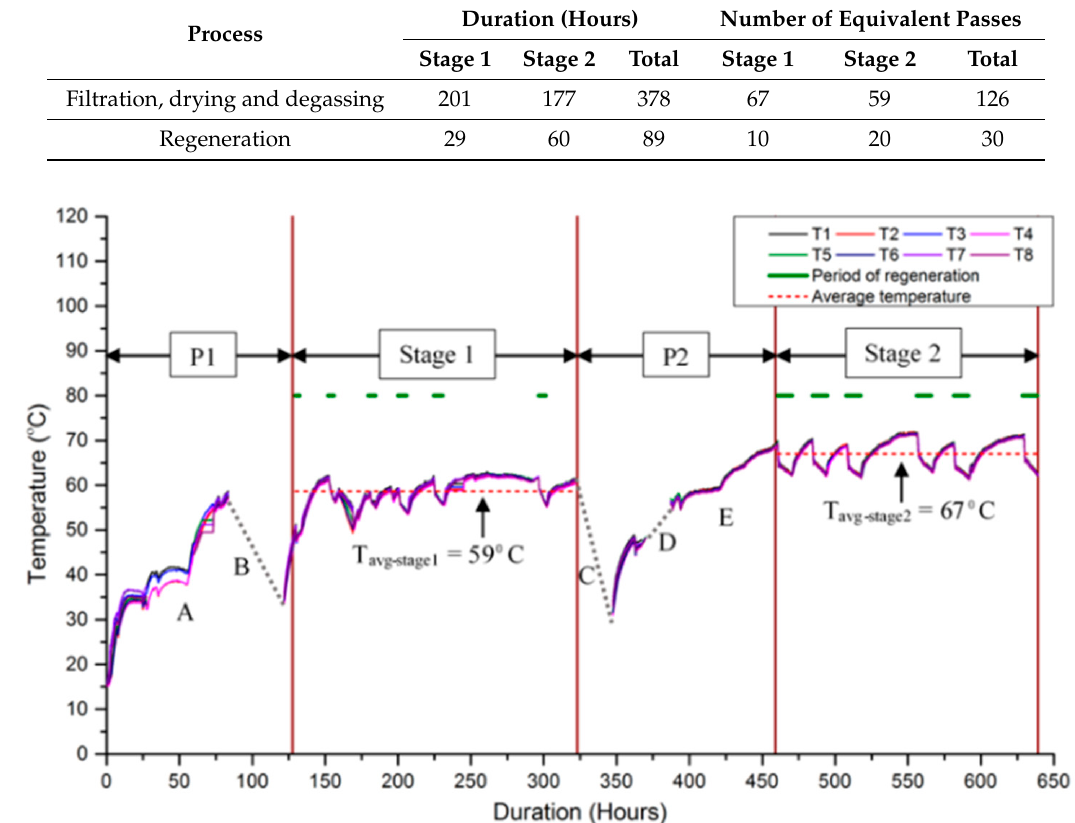
Figure 4. Temperature profile during the regeneration experiment.